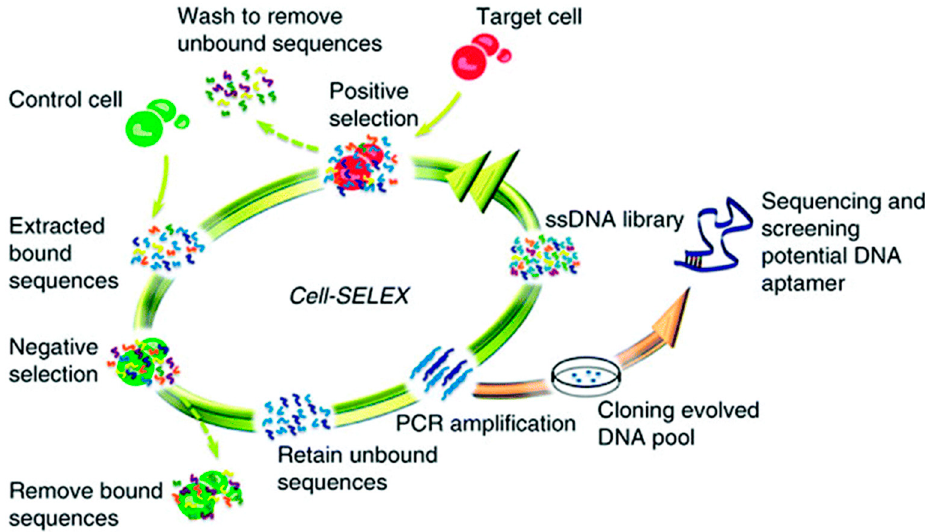
Figure 20. Systematic evolution of ligands using exponential enrichments (SELEX) isolation strategy, applied to RNA aptamer preparation [102]. Reprinted from Analyst , Vol. 141, C. Jin, L. Qiu, J. Li, T. Fu, X. Zhang, and W. Tan, “Cancer biomarker discovery using DNA aptamers,” pp. 461–466, Copyright 2016, with permission from the Royal Society of Chemistry.